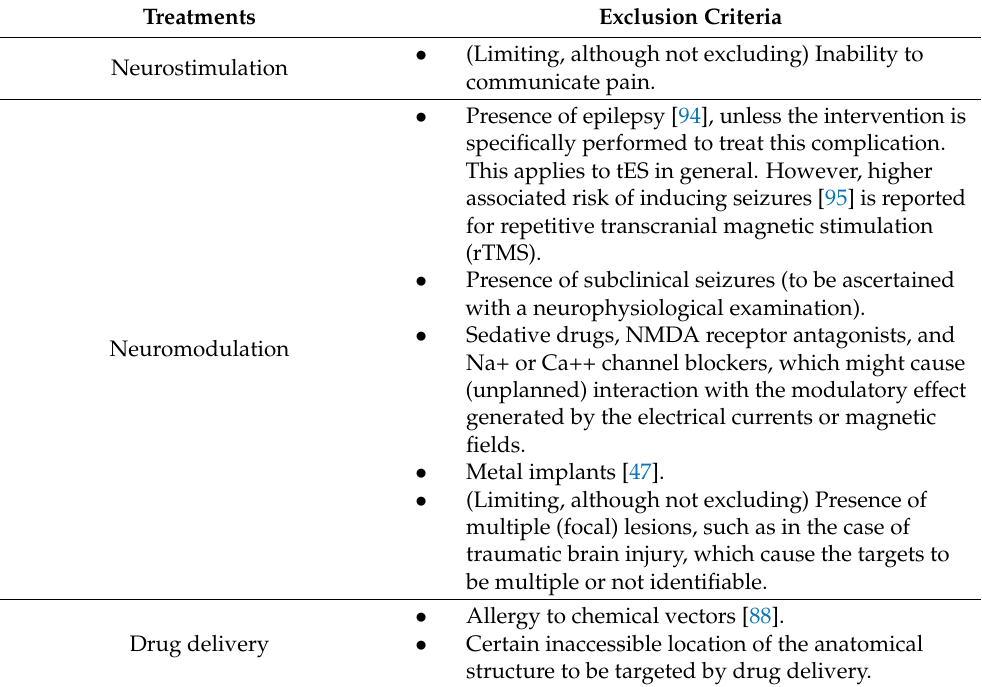
Table 2. Exclusion criteria for non-invasive brain stimulation, brain modulation, and drug delivery. Treatments Exclusion